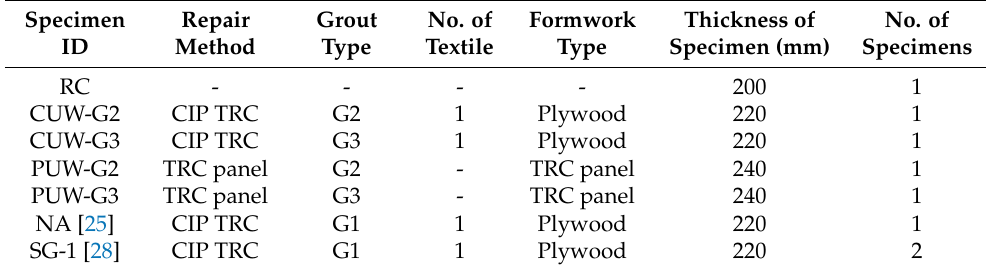
Table 6. Characteristics of specimens for flexural test.